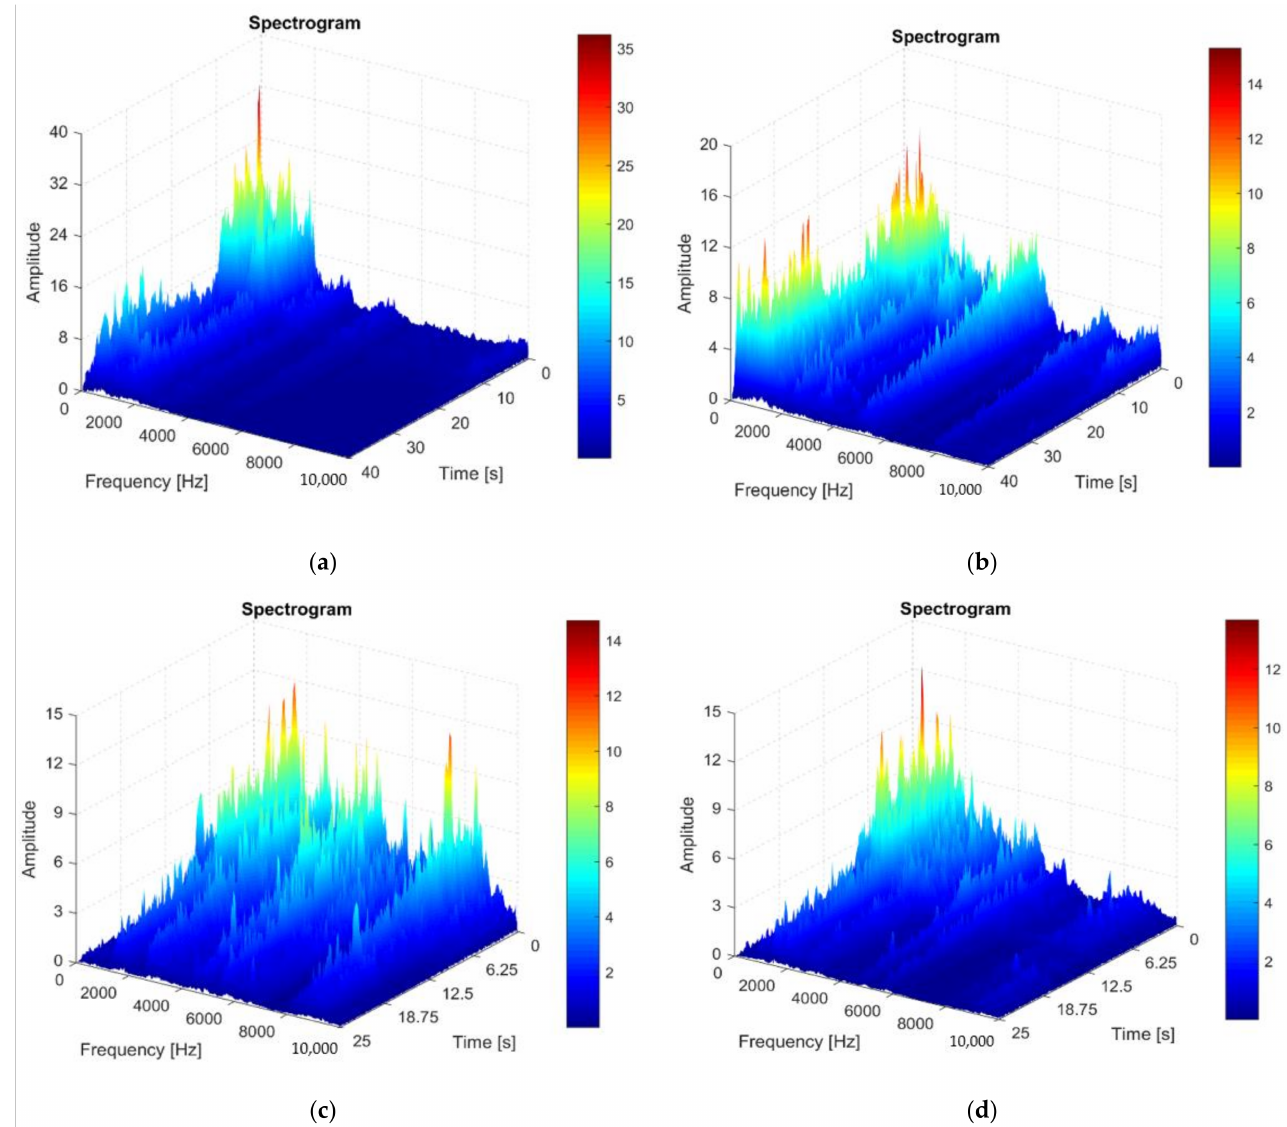
Figure 7. The spectrogram of vibration recorded during machining: ( a ) in the Z direction in the case of machining with tool T01; ( b ) in the Y direction in the case of machining with the cutting tool T01; ( c ) in the Z direction in case of machining with the cutting tool T02; ( d ) in the Y direction in the case of machining with a T02 cutting